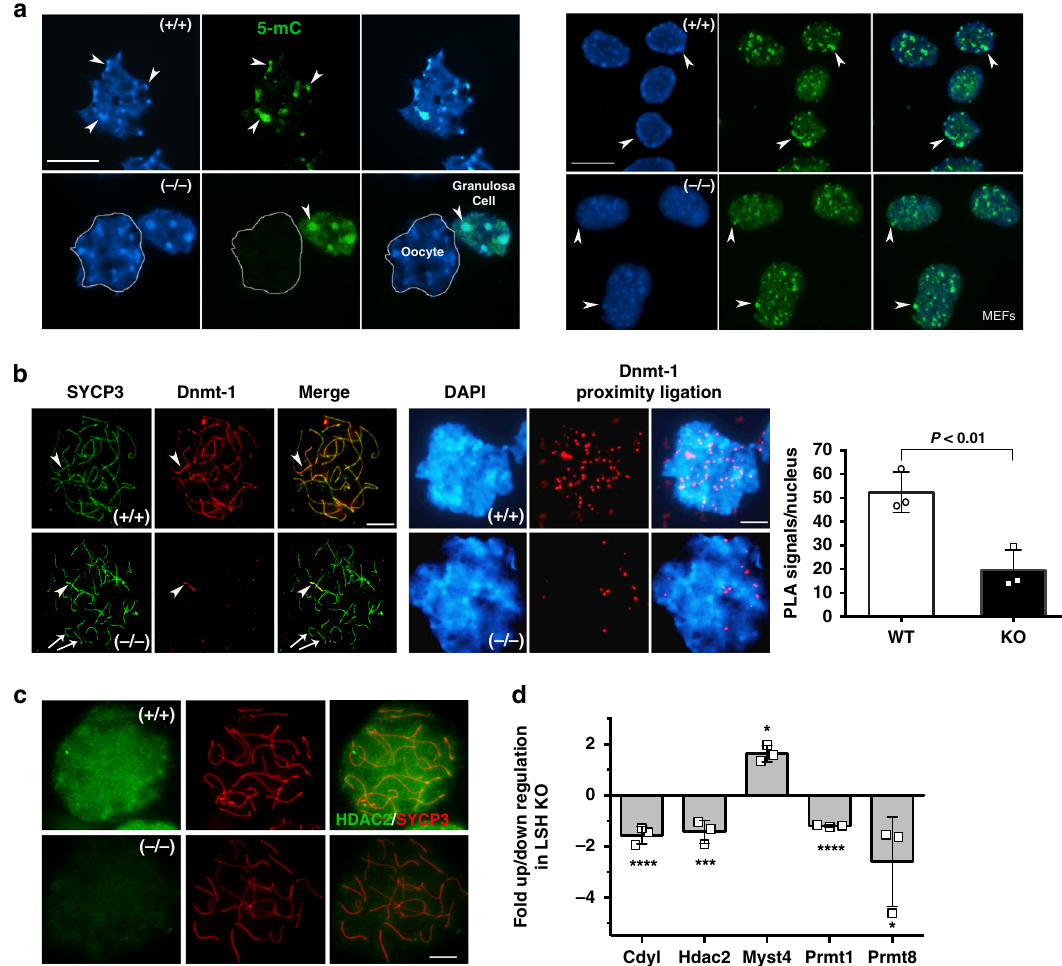
Fig. 3 LSH knockout results in reduced DNMT-1 and HDAC2 in pachytene oocytes. a LSH exhibits a germ cell-speci fi c role in centromere cytosine methylation. 5-methyl Cytosine (5-mC; green) is enriched at pericentric heterochromatin domains (arrowheads) detected by bright DAPI staining in wild- type pachytene oocytes. LSH mutant oocytes lack 5-mC staining at pericentric heterochromatin. However, granulosa cells of LSH mutant ovaries exhibit normal levels of 5-mC staining at heterochromatin domains. No differences were detected in the patterns of 5-mC staining in somatic cells (embryonic fi broblasts; MEFs) of wild-type and LSH mutant embryos on day E14 (scale bar = 10 μ m). b DNMT-1 associates with the synaptonemal complex in wild- type late pachytene oocytes ( n = 53) on embryonic day E17.5. However, confocal microscopy and proximity ligation assays revealed a signi fi cant reduction in DNMT-1 in LSH − / − oocytes ( n = 52). Data show the mean ± SD of three independent replicates (scale bar = 5 μ m). Unpaired t -test, two tailed and resulted in P = 0.0093. c HDAC2 is an abundant nucleoplasmic protein in wild-type oocytes at the pachytene stage. LSH knockout induces a signi fi cant reduction of HDAC2 in pachytene oocytes. d LSH mutant ovaries also exhibit a signi fi cant reduction in transcripts for HDAC2 (*** P = 0.0007), the chromodomain CDYL (**** P = 0.0002) and the arginine methyltransferases PRMT-1 (**** P < 0.0001) and PRMT-8 (* P = 0.0237), and show increased transcripts for the histone acetyl transferase MYST4 (* P = 0.0266). Plot of expression values represent the log2 fold change showing signi fi cant differences in transcript levels after analysis of 84 chromatin-modifying enzymes compared to housekeeping genes (Actin, Gapdh, Hsp90ab1, Gusb) as internal controls. Data represent the mean ± SD of three independent replicates (scale bar = 5 μ m). Statistical analysis was conducted using unpaired t - tests, two